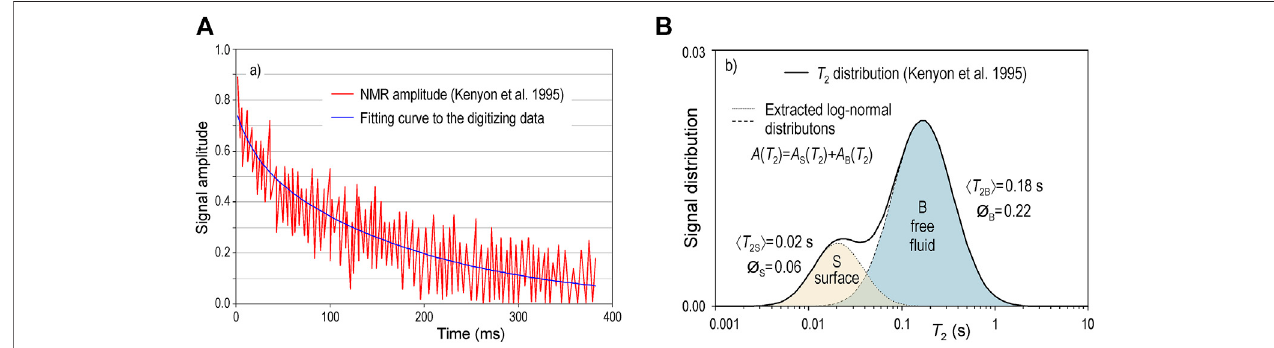
FIGURE 5 | Example of a T 2 distribution adapted from Kenyon et al. (1995). (A) signal amplitude and fi tting curve to the digitizing data. (B) signal distribution.